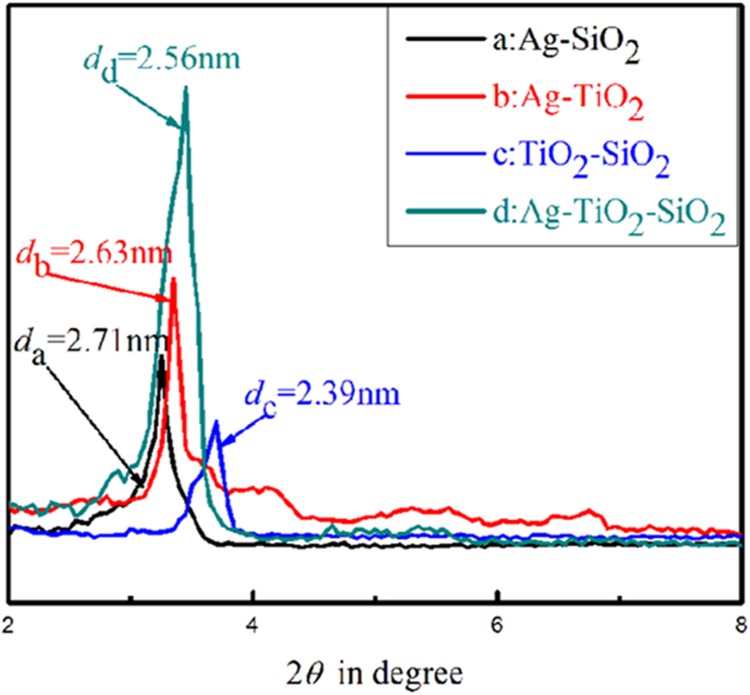
LAXRD patterns of TiO2-SiO2 and Ag-TiO2-SiO2.